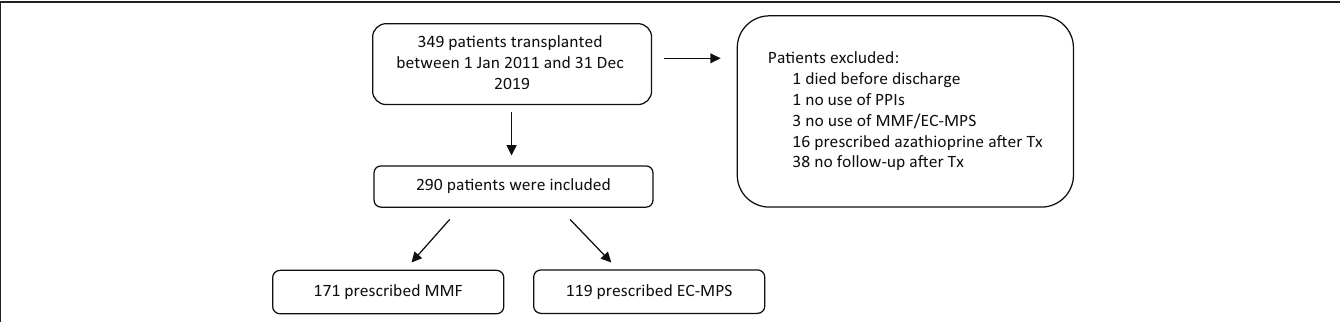
Figure 1. Flow diagram of the patient selection process. EC-MPS, enteric-coated mycophenolate sodium; MMF, mycophenolate mofetil; PPIs, proton pump inhibitors; Tx,